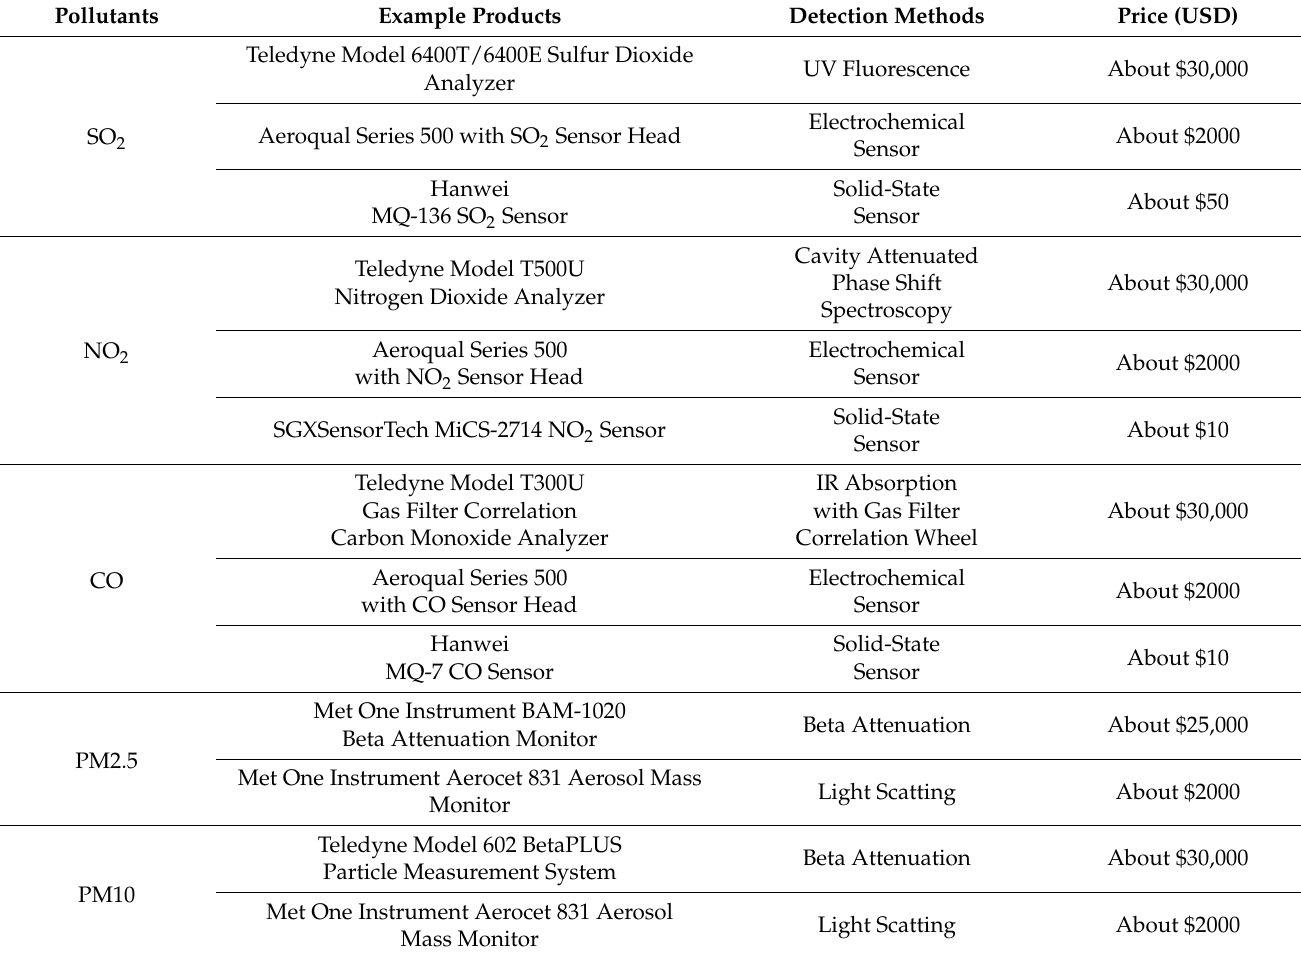
Table 5. Some traditional testing instruments (Adapted from